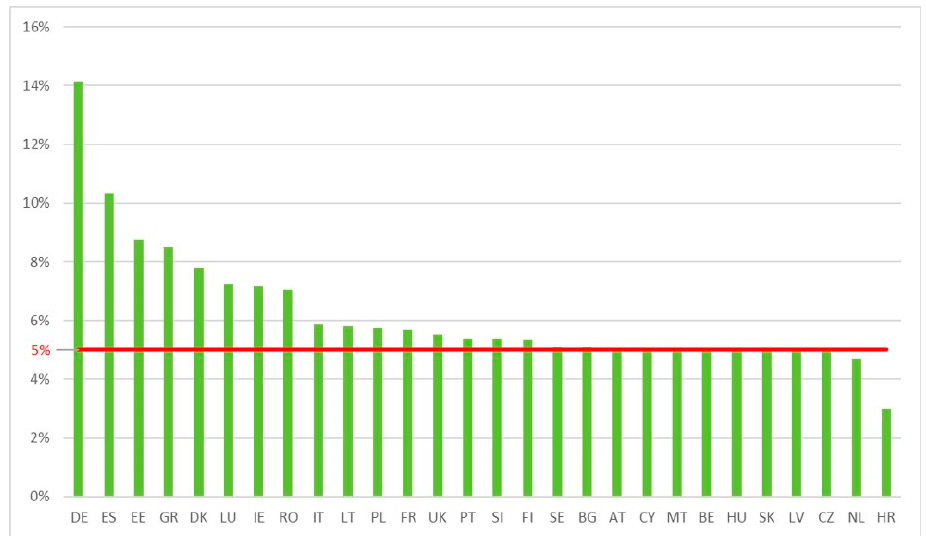
Figure 3. Share of CLLD (LEADER) allocation of EAFRD by country, 2014–2020 [7]. Note—red line represents the minimum requirement of 5% of EAFRD funding for LEADER.